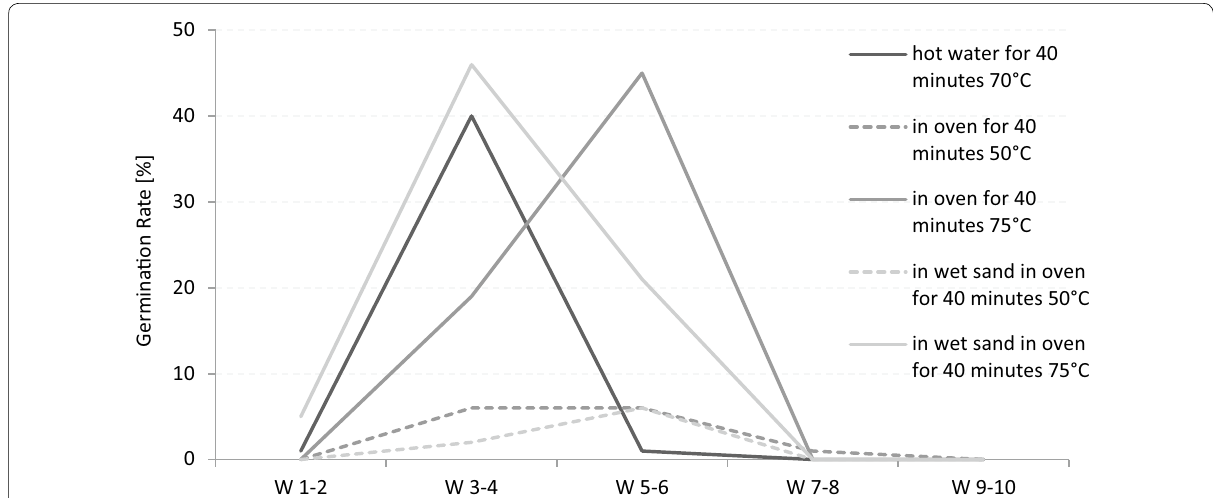
Fig. 1 Adansonia digitata seed‑germination during 10 weeks (W) after heat treatment. Blue: 70 °C hot water for 40 min. Red: Dry conditions in oven for 40 min. Orange: Wet conditions in the oven for 40 min. Dashed lines: 50 °C, solid lines: 75 °C